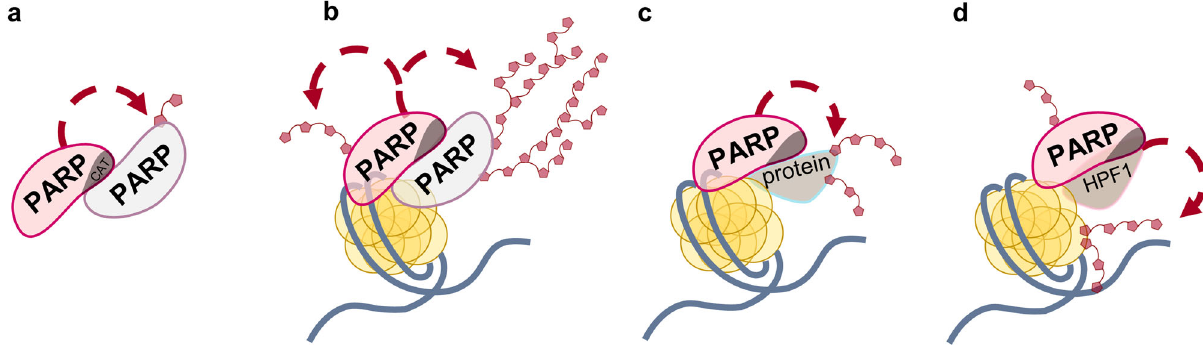
Fig. 1 Different catalytic activities of PARPs. a The basal (DNA-independent) activity; b the DNA-dependent automodi fi cation suggested to occur in cis and trans 40 ; c the DNA-dependent heteromodi fi cation of target protein 40 ; d the HPF1-induced heteromodi fi cation of